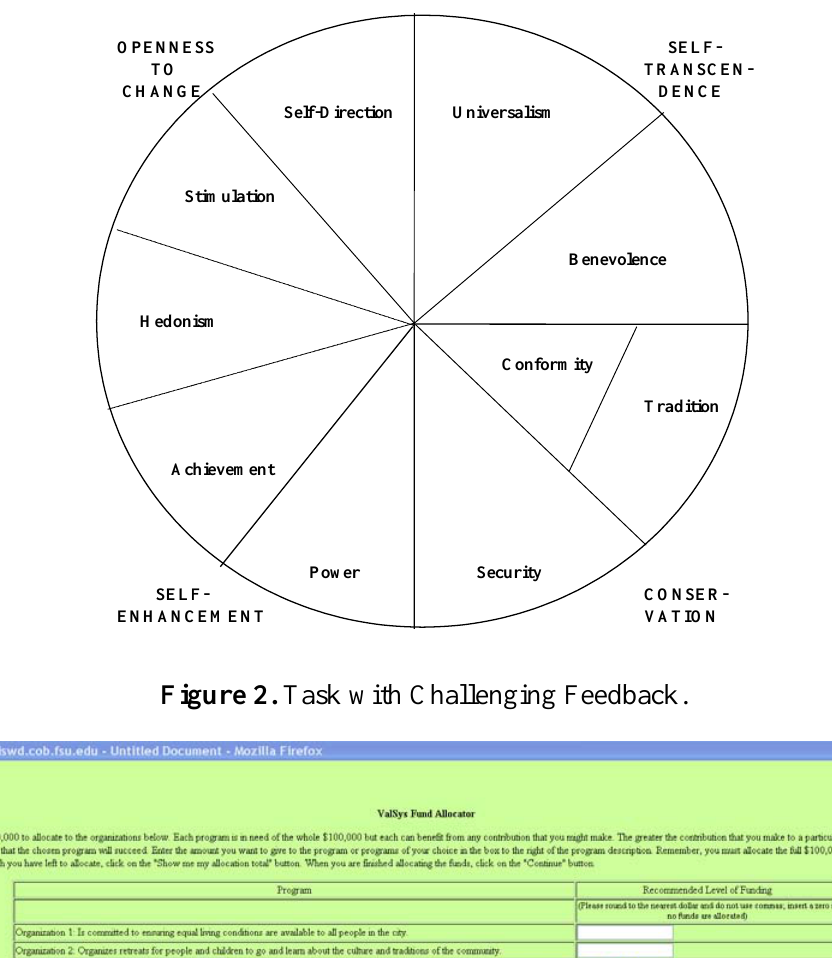
Figure 1. Relationships among the Value Constructs [18].